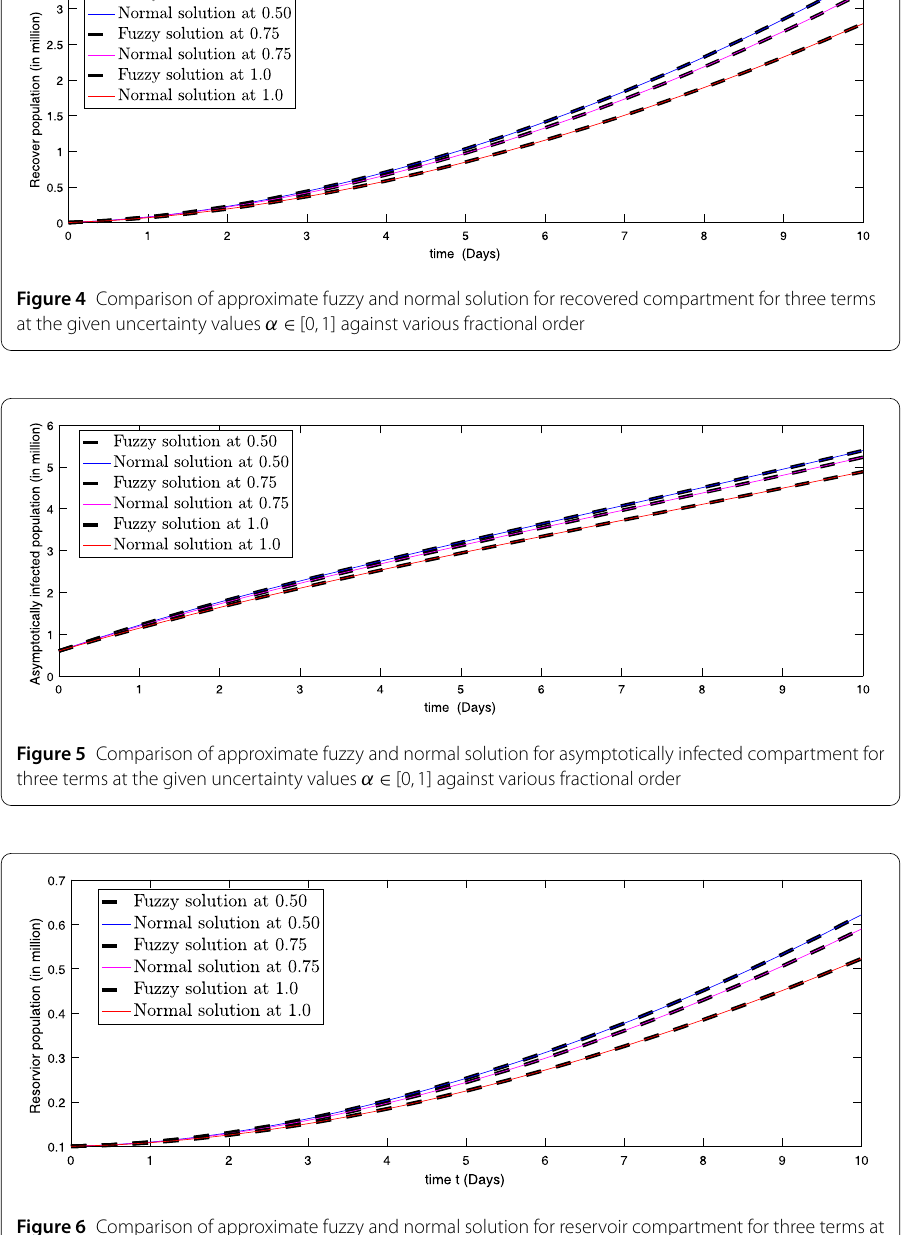
Figure 6 Comparison of approximate fuzzy and normal solution for reservoir compartment for three terms at the given uncertainty values α ∈ [0,1] against various fractional